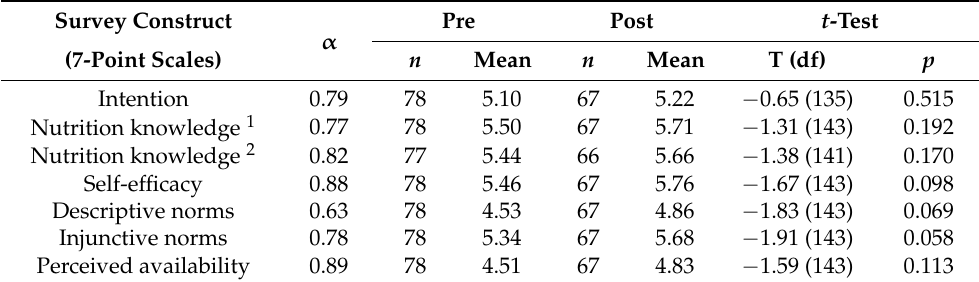
Table 3. Survey measures: pre ( n = 79) and post ( n = 67) communication